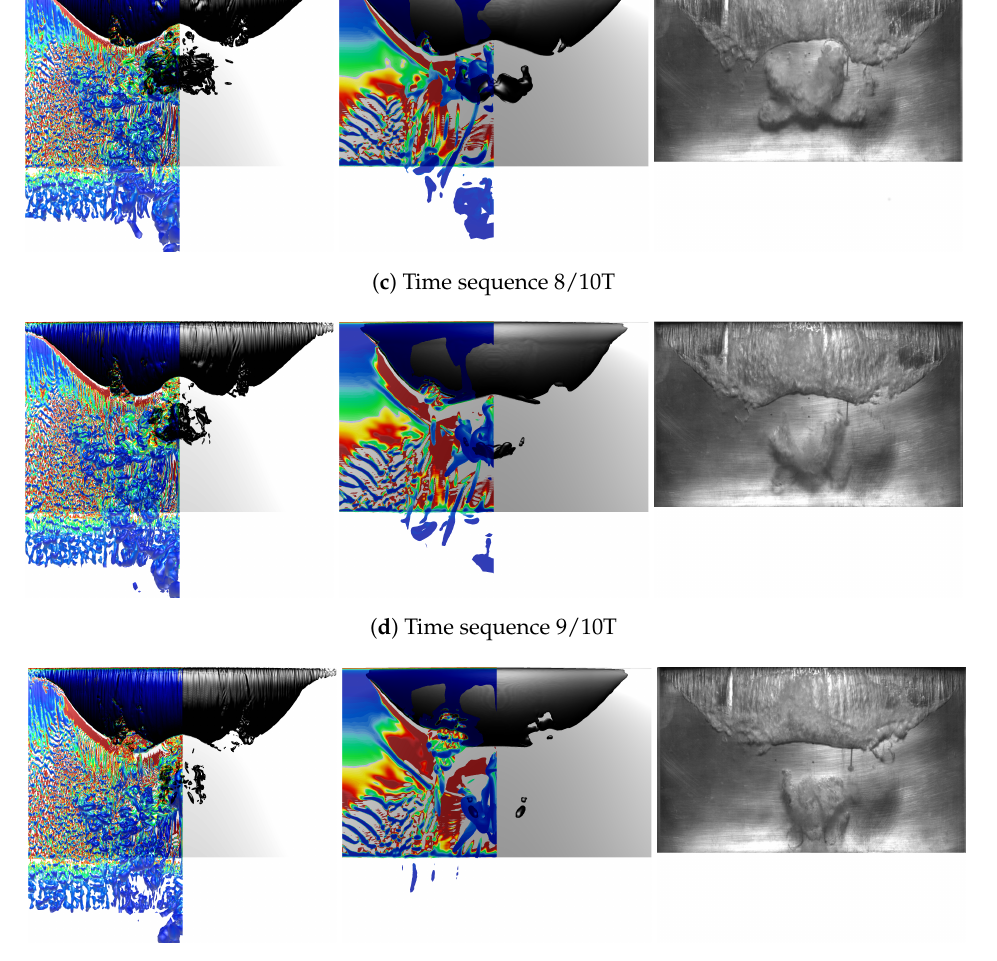
Figure 9. Cloud cavitation transportation and